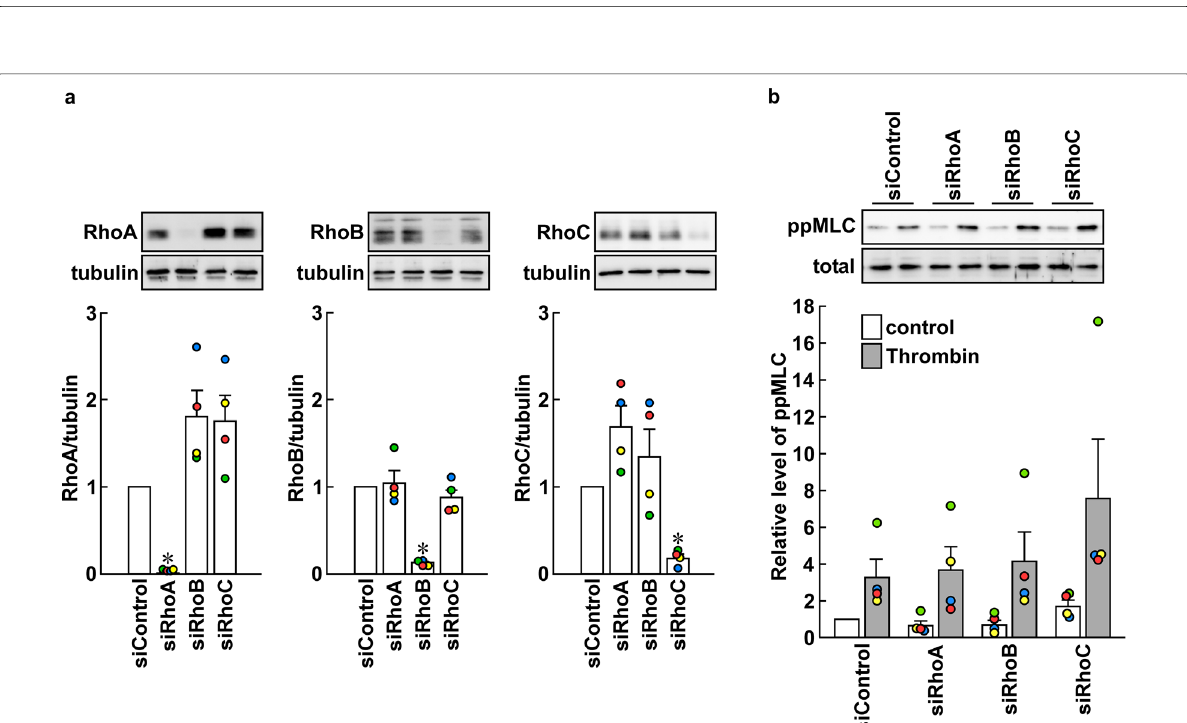
Fig. 6 Effect of knockdown of RhoA, RhoB and RhoC on thrombin-induced di-phosphorylation of myosin light chain (ppMMLC) in porcine aortic endothelial cells (PAECs). Representative immunoblot images and summaries of immunoblot detection of RhoA, RhoB and RhoC ( a ), and ppMLC before and 3 min after stimulation with 1 unit/mL thrombin ( b ). The samples obtained before thrombin stimulation were used to detect Rho proteins. The data are expressed as mean SEM ( n 4). * P < 0.05 vs. the other conditions according to an ANOVA followed by Fisher post hoc ± = test. In b, the values of siRhoA, siRhoB and siRhoC before and after thrombin stimulation showed no significant difference from those of siControl, according to an ANOVA followed by Dunnett’s post hoc text. All original images of the immunoblot analyses are shown in Additional file 1: Figure